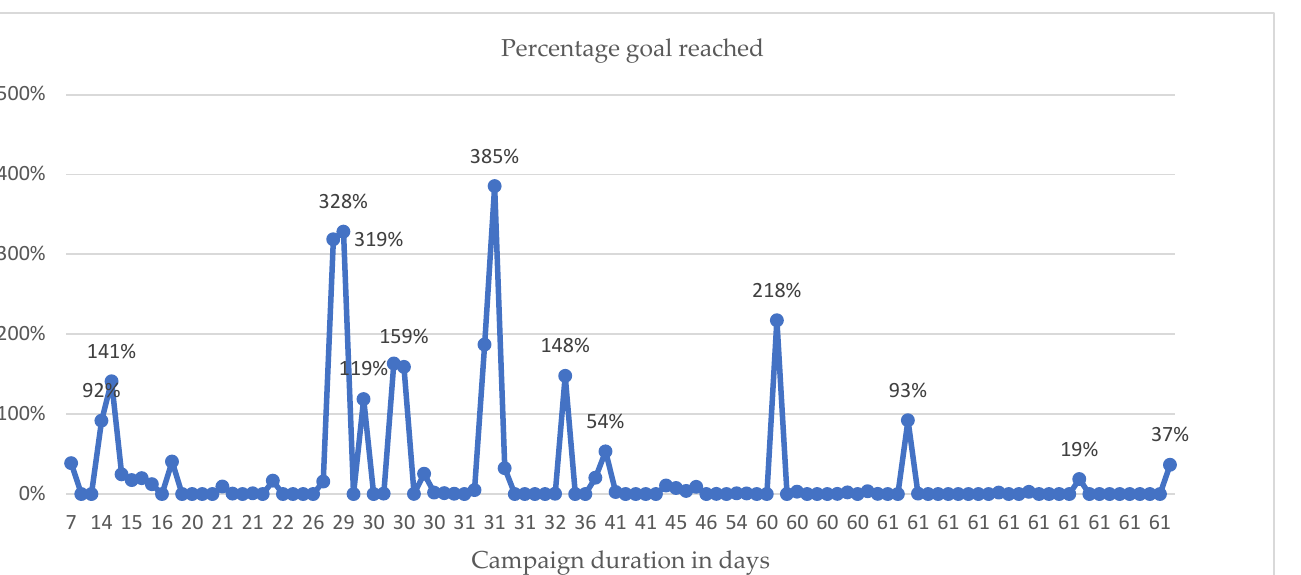
Table 6. Descriptive Statistics and Correlation Matrix.